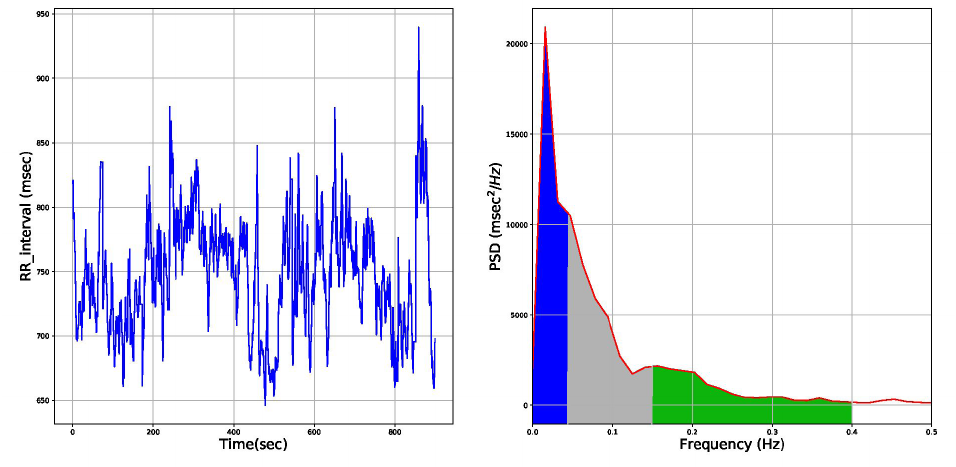
Figure 4. ( A ) Periodogram of a 15-minute ECG recording, illustrating the HRV over time; ( B ) Power spectral density graph obtained by FFT from the recording shown in panel A, indicating the areas corresponding to each frequency band. (VLF: 0.003 – 0.04 Hz, LF: 0.04 – 0.15 Hz, HF: 0.15 – 0.4